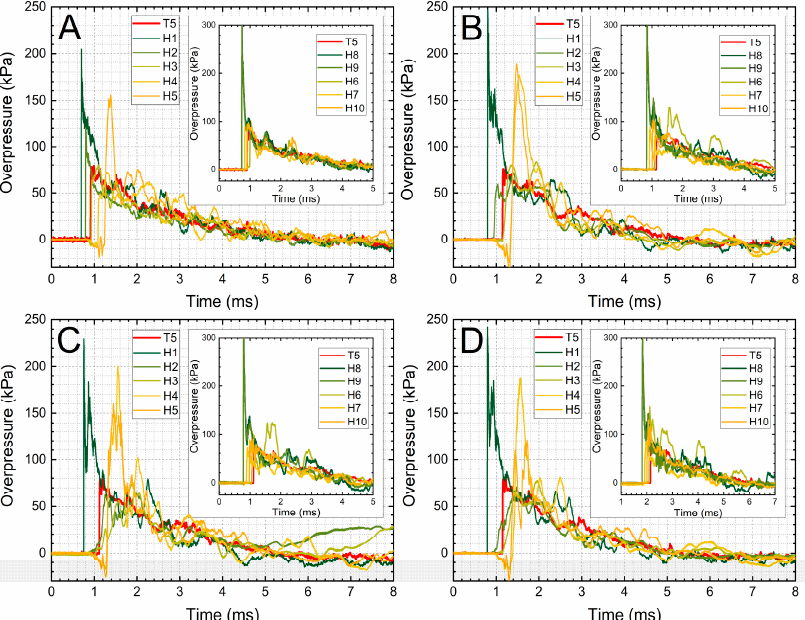
Figure 5. The evaluation of the three helmets under shock wave loading conditions. The representative overpressure waveforms recorded at a nominal shock wave intensity of 10 psi (70 kPa, denoted as T5). The headform with no helmet ( A ) or equipped with the Ops-Core ( B ), Airframe ( C ), or ECH ( D ) helmets were used in these experiments. The data recorded by the midsagittal (H1–H5) and circumferential (H6–H10, insets) sensors embedded in the headform are presented.